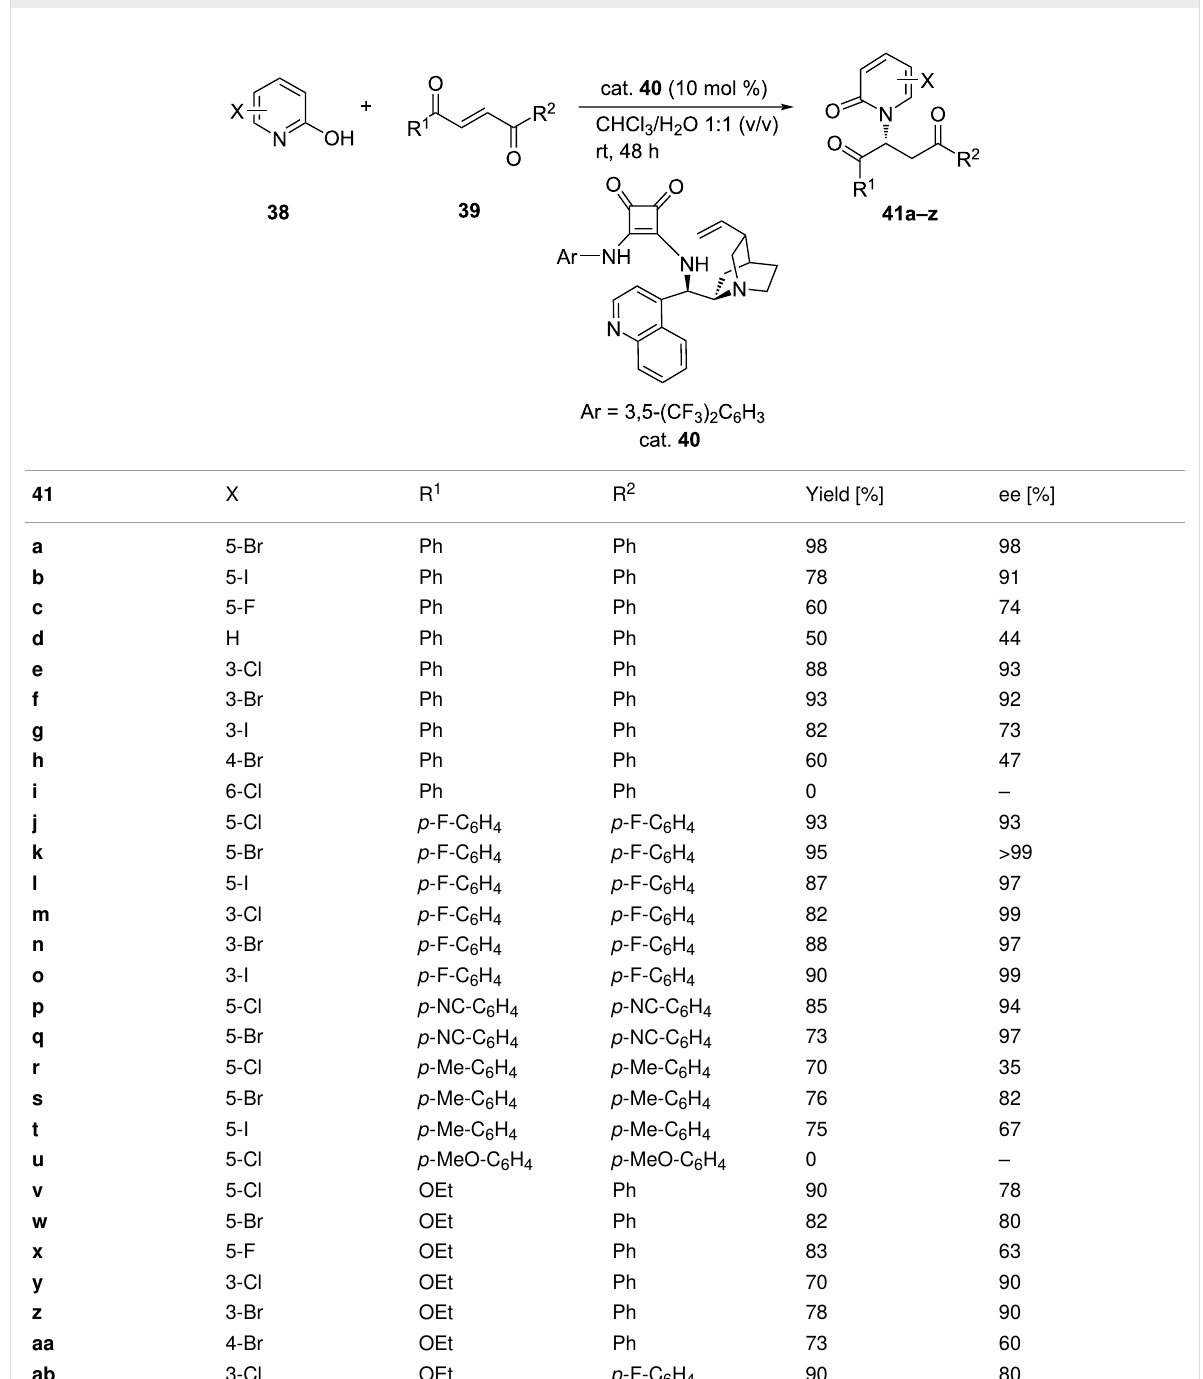
Table 8: Asymmetric aza-Michael synthesis of N -substituted